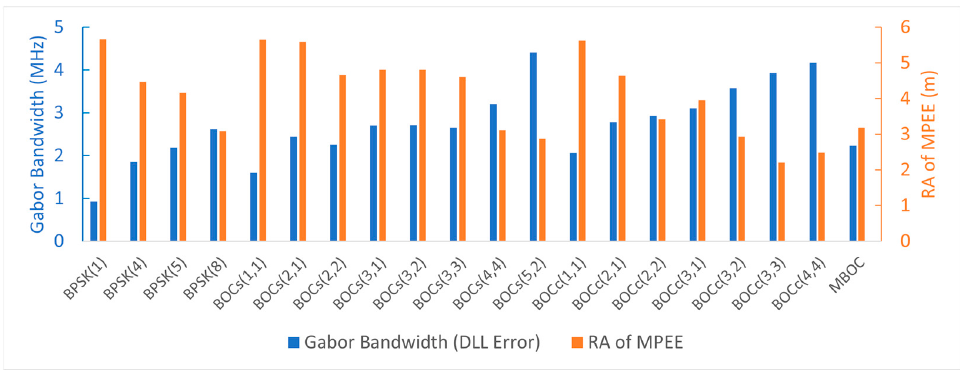
Figure 10. The Gabor bandwidth and the RA of the MPEE for each candidate. As seen in Figure 11, the AMSR of the BPSK signals was close to zero. BOC s (3,1) and BOC c (3,1), which had the highest modulation order, had high AMSRs of 0.67 and 0.70, respectively. Since a signal with a high AMSR requires a relatively complex receiver implementation, BPSK modulation schemes are preferred for civilian uses.